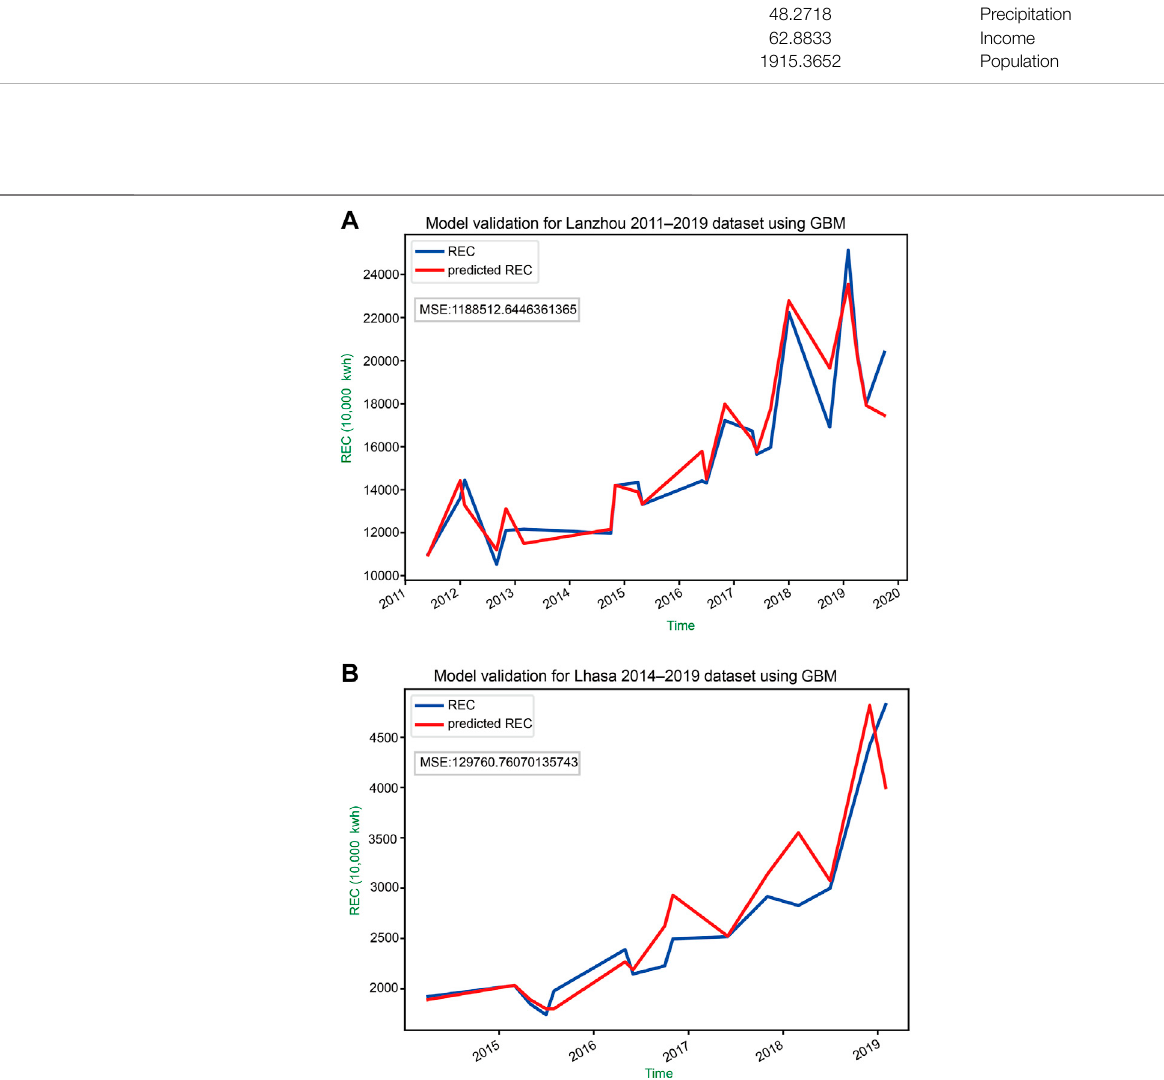
Frontiers in Earth Science |